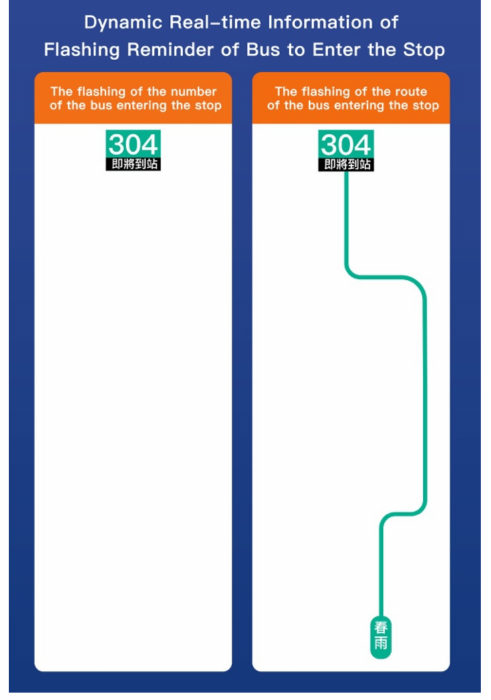
Figure 3. Dynamic real-time information of flashing reminder of a bus entering the